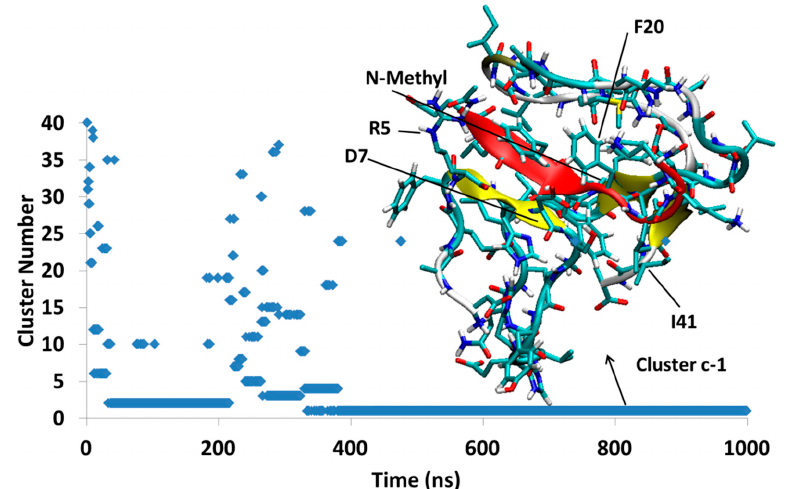
Figure 10. A β 42 -SGD1-c: The first cluster, Dc1, exists almost through all of trajectory, with no β -sheet with R region. The total number of clusters through 1 μ s was only 40.